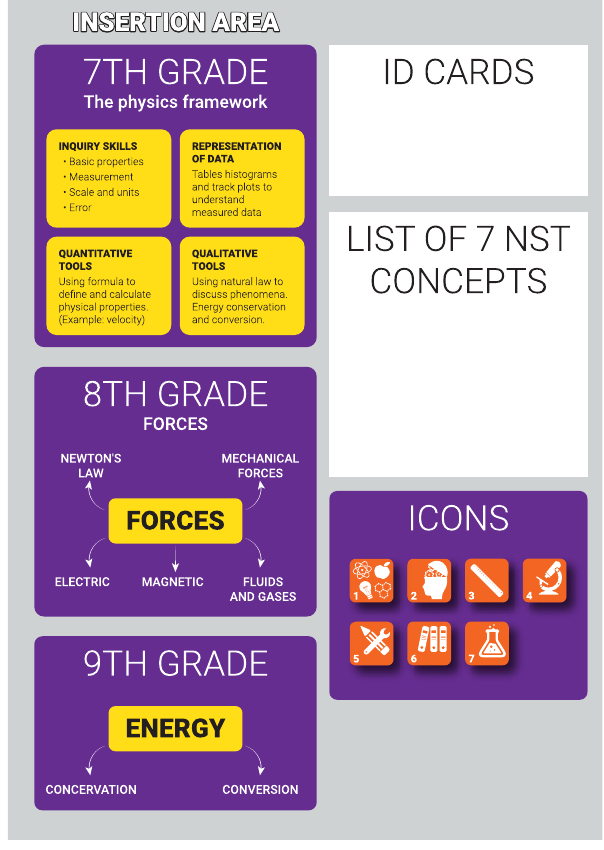
FIG. 1. A schematic of the designed discourse board. In the white area of the board, the interviewer placed the NST concept cards during the discourse; the cards contain information about the NST